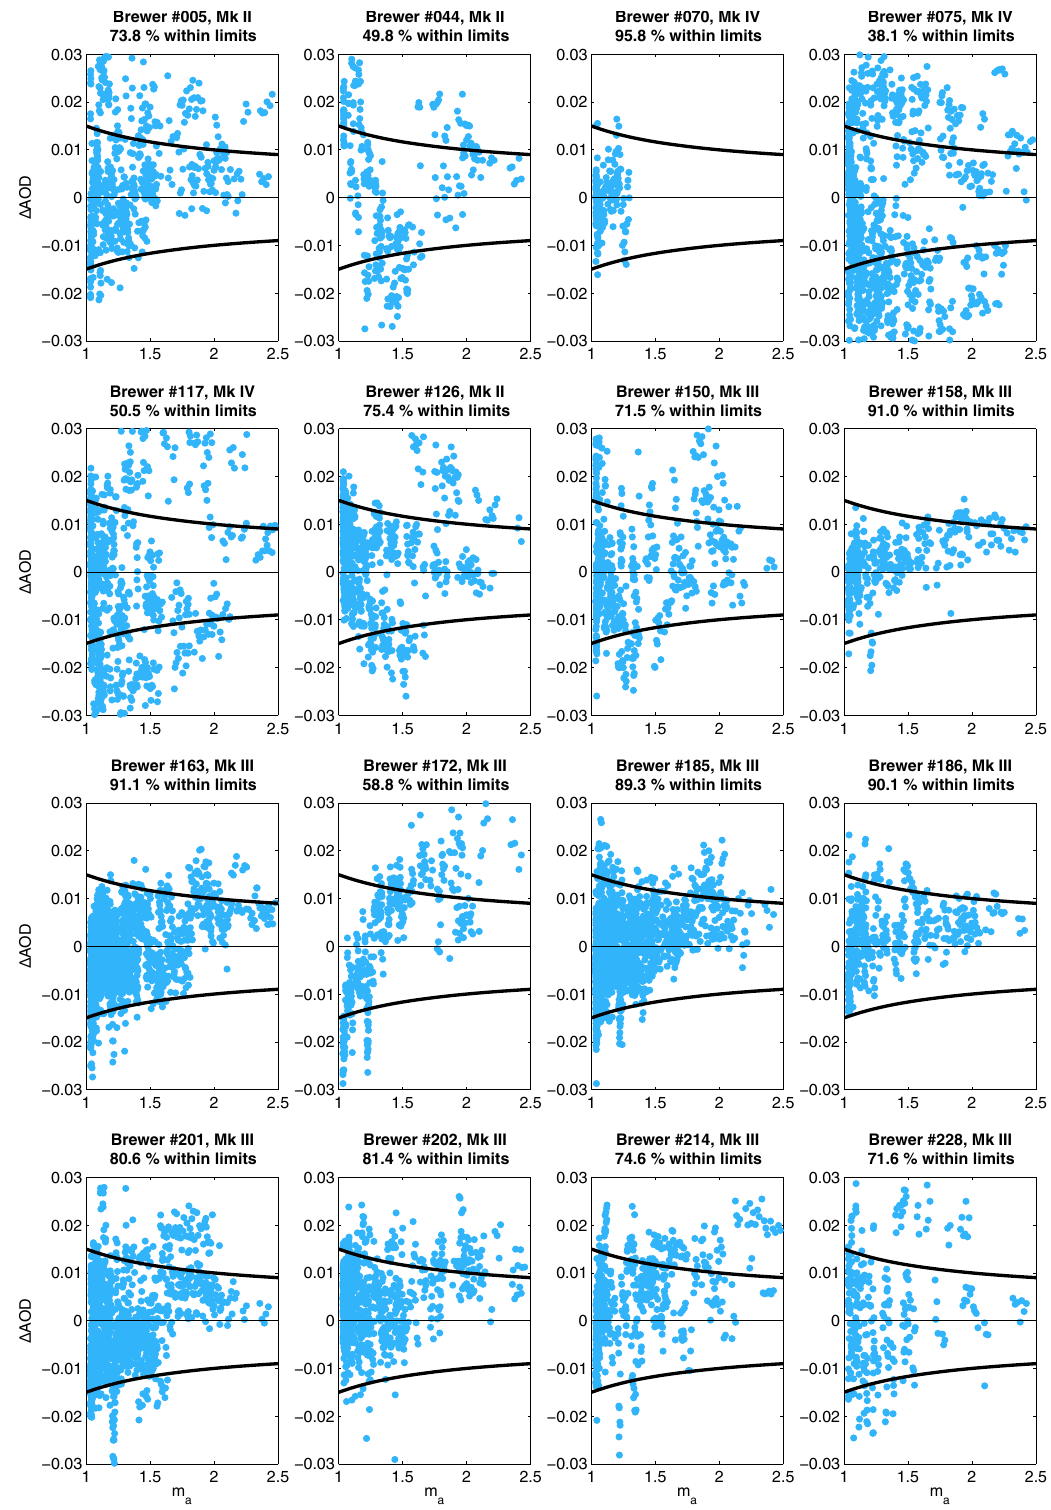
Figure 4. AOD differences, for observations within 1min at 313.5nm, between the Brewer instruments and the UVPFR during the tenth intercomparison campaign of the RBCC-E, plotted as a function of the aerosol optical air mass. The UVPFR data have been interpolated from those at wavelengths 311.3 and 317.5nm using the Ångström relationship. The WMO traceability limits for finite field-of-view instruments (Eq. 11) are shown as thick black